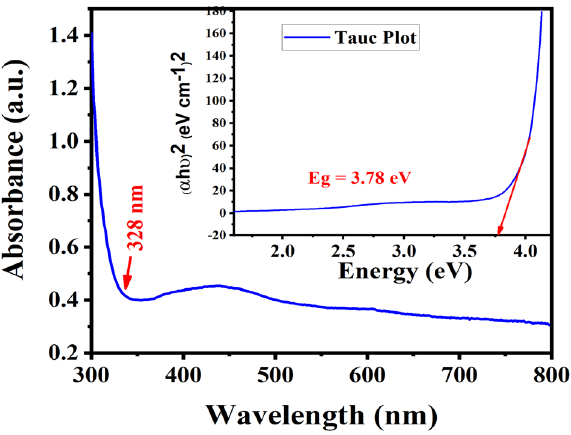
Figure 10. UV–Visible spectrum and Tauc Plot for Sr 1−x Al 2 O 4 :Eu x (x = 0.05) phosphor (SAE phosphor).